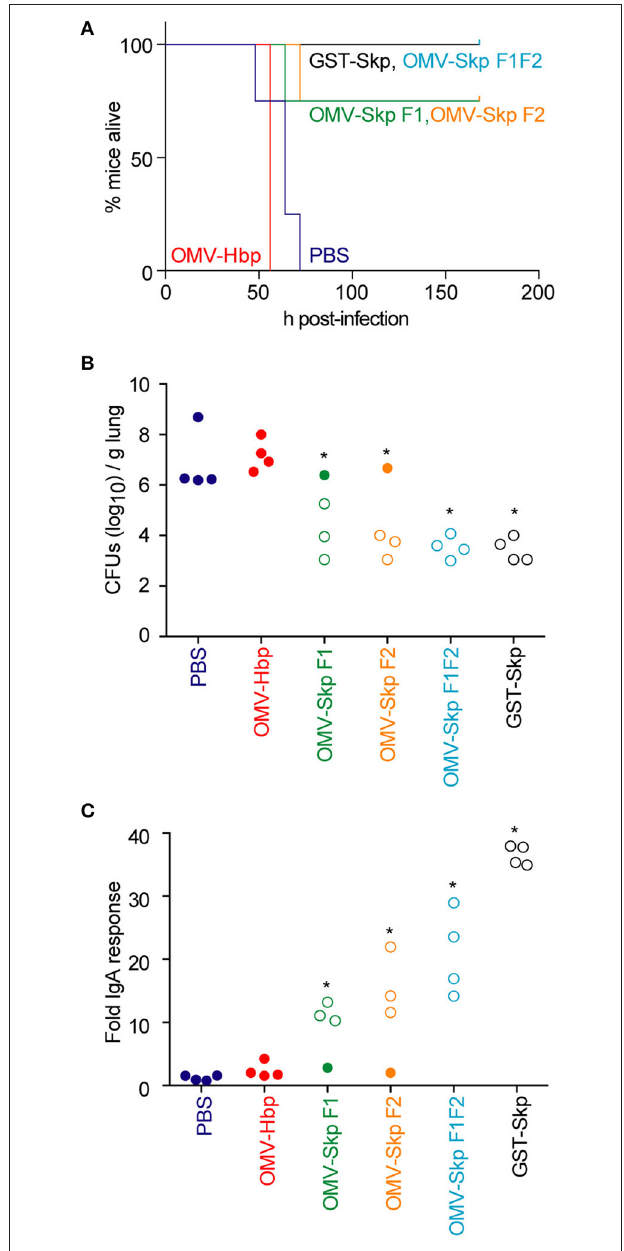
FIGURE 2 | Impact of vaccination on mouse survival after pulmonary challenge with ETEC (A) . Mouse survival is plotted as a function of time (h) after mice were inoculated with ETEC H10407 following intranasal immunization with the indicated antigens, n = 4. Asterisks indicate significantly different ( p < 0.05) mouse survival, log-rank test (B) . ETEC loads (CFUs/g lung) in mice infected with ETEC H10407 at time of euthanasia or at the end of the study (7 days). Open symbols indicate mice that survived for the duration of the study. Closed symbols indicate mice that were euthanized due to their display of clinical signs of illness, n = 4. Asterisks indicate significantly different ( p < 0.05) ETEC loads in mouse lungs, Kruskal-Wallis test (C) . Fold change in mouse fecal IgA concentrations after immunization with the indicated antigens. Open symbols indicate mice that survived for the duration of the study. Closed symbols indicate mice that were euthanized due to their display of clinical signs of illness. n = 4. Asterisks indicate significantly different ( p < 0.05) fecal IgA concentrations, Kruskal-Wallis